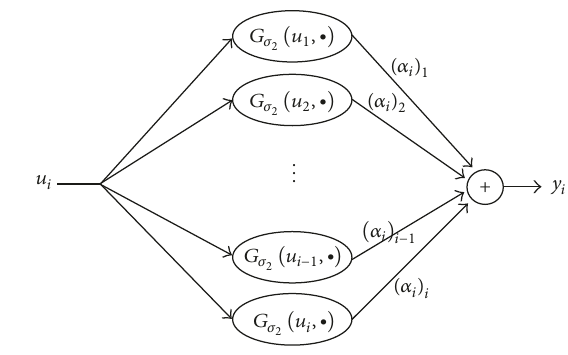
Figure 2: Network topology of GKRMC at i th